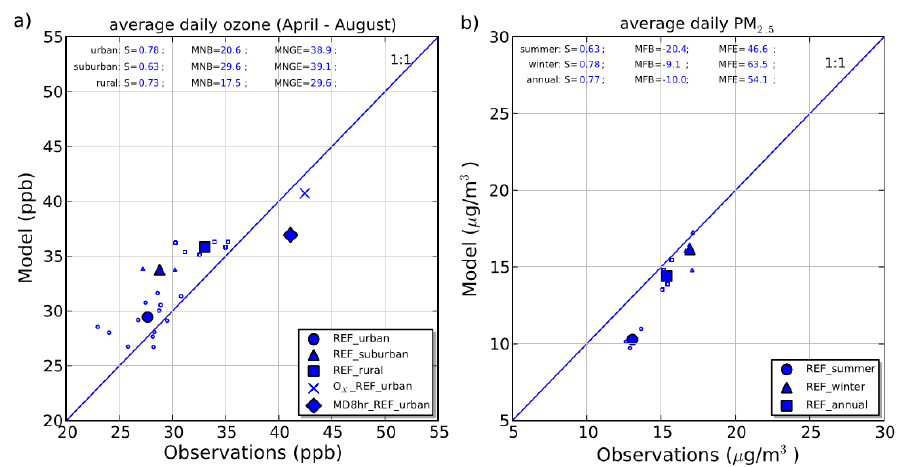
Figure 3. (a) Scatter plots and scores of daily average ozone concentrations at urban, suburban and rural stations from the REF simulation. Odd oxygen (O x ) and daily maximum values at urban locations are also shown. textbf(b) daily average PM 2 . 5 concentrations in wintertime (DJF), summertime (JJA) and on annual basis over urban